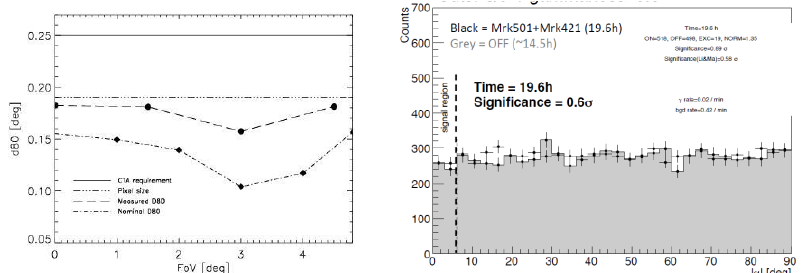
Figure 1. Left : Comparison of D80 (diameter of the circle corresponding to an encircled energy of 80%) as a function of field angle (off-axis) between its ideal (dot-dashed curve) and measured at ASTRI SST-2M (dashed curve) values. SiPM pixel size (dashed horizontal line) and CTA requirement (solid horizontal line) are also shown. The requirement of a flat PSF of  10 arcmin along a large field of view (  10°) is clearly fulfilled. Right : |  | distribution of the stacked Mrk421 and Mrk501 signal and background estimation from data taken in June/July 2018, after an 80% efficiency-based gamma/hadron discrimination parameter cut (in the whole energy range). The region between zero and the vertical dashed line (at 6 deg) represents the fiducial signal